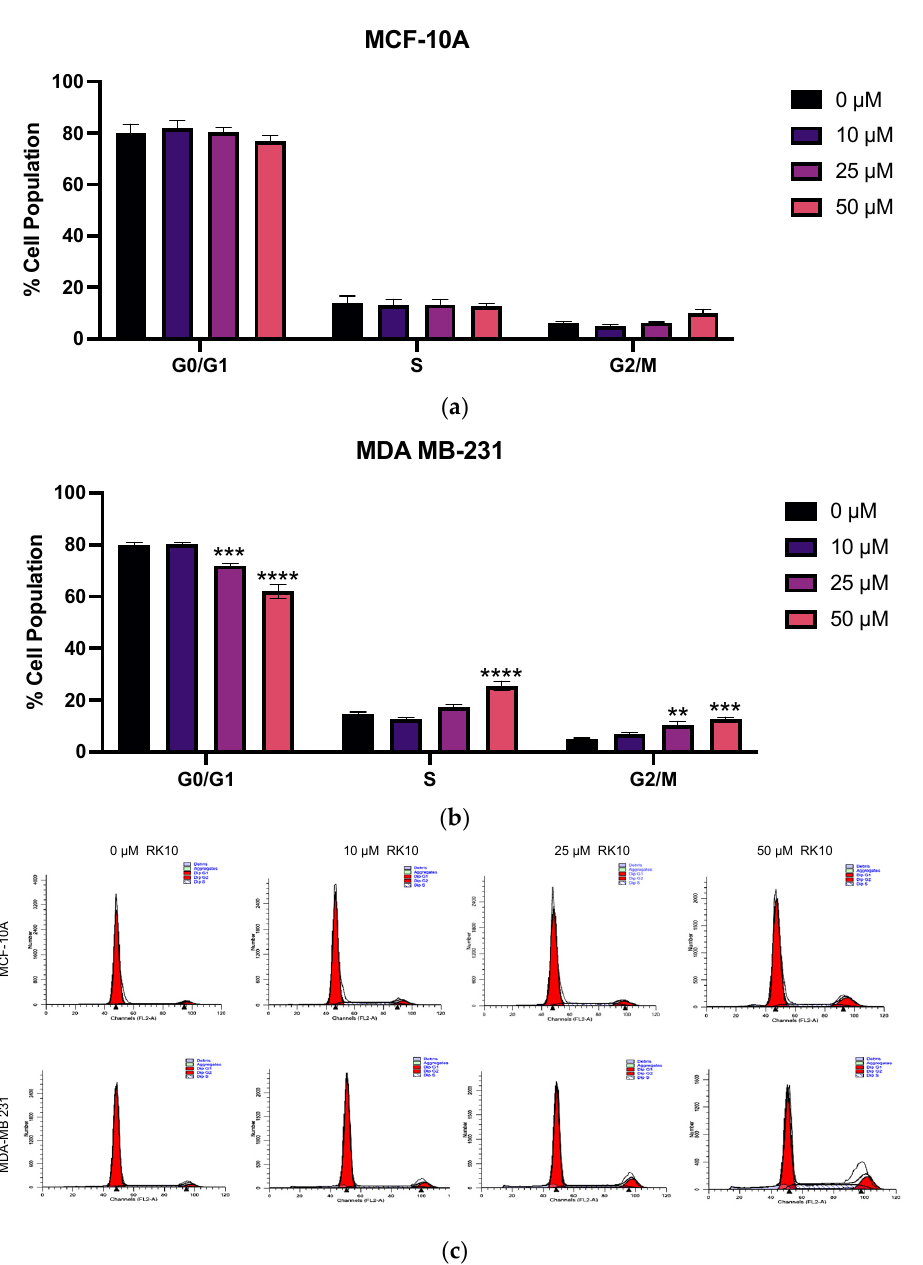
Figure 7. RK-10 induces S and G2/M cell cycle arrest. ( a ) MCF-10A and ( b ) MDA-MB 231 cells were treated with 0, 10, 25, and 50 µM of RK-10 for 48 h. Afterwards, the cells were fixed, stained, and flow cytometry was performed. ( c ) Representative histograms of the flow cytometry profiles monitoring cell cycle progression as determined by the distribution of DNA content. Student’s t -tests were performed, and treatments were compared to the DMSO control. Results are expressed as the means ± SDs (**** p < 0.0001, *** p < 0.001, ** p < 0.01), and data are representative, from one of at least three independent experiments.